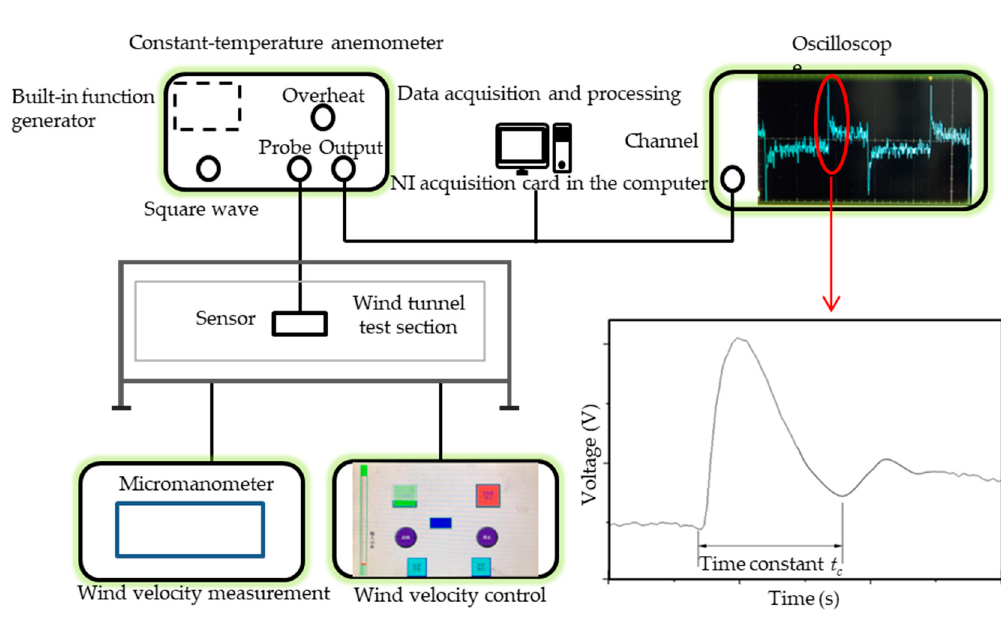
Figure 3. Schematic diagram of square wave and wind tunnel tests.